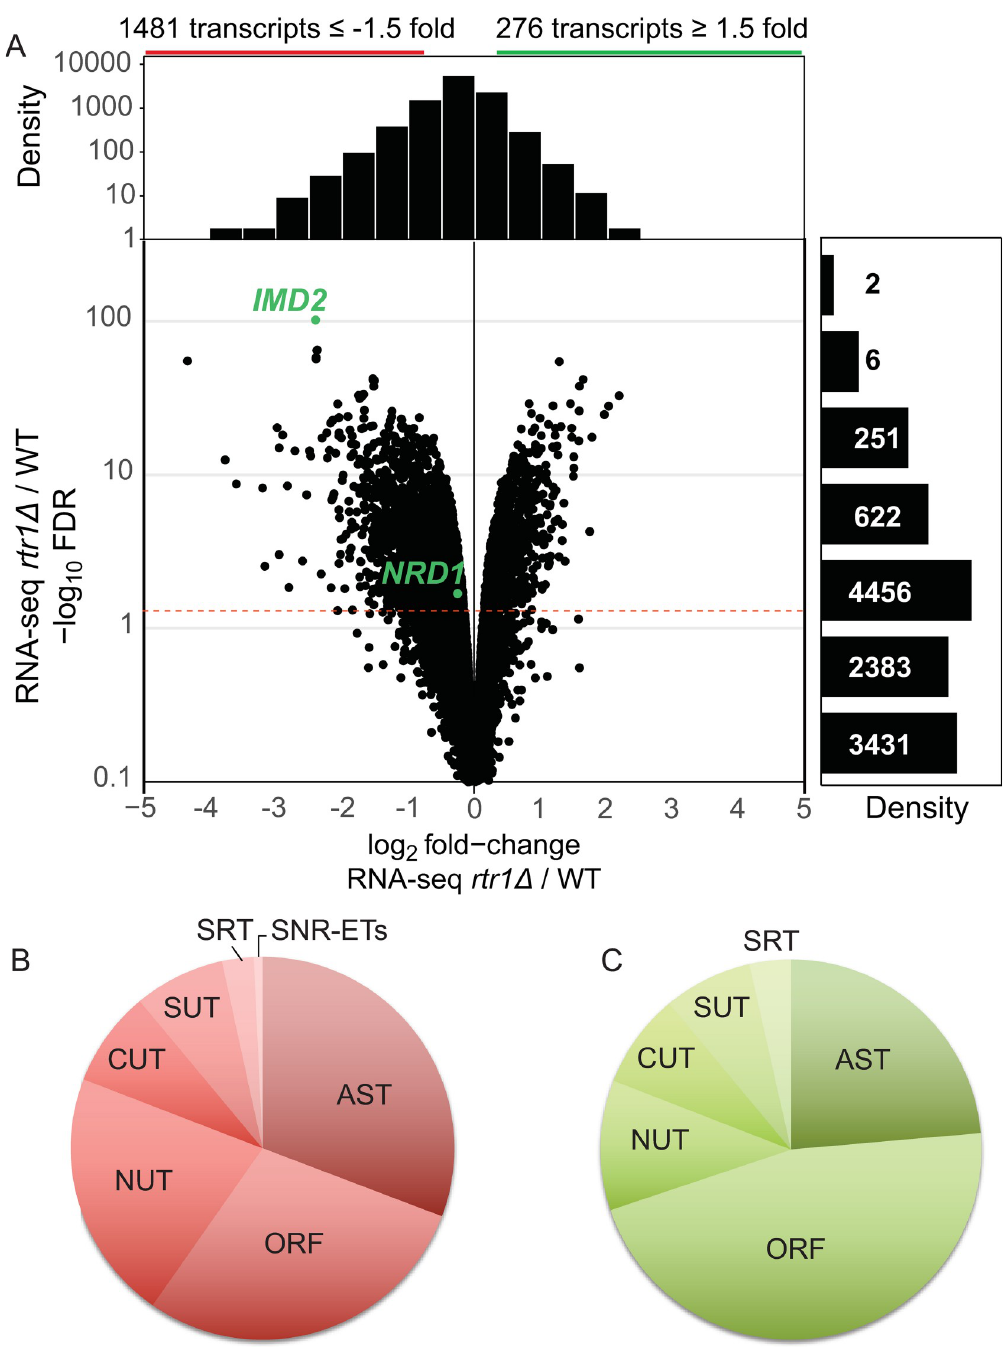
Fig 2. Loss of Rtr1 activity causes wide-spread changes in RNA expression in yeast. A) Volcano plot for normalized RNA-Seq data for RNA transcripts in rtr1 Δ vs. WT cells (n = 4, edgeR analysis). Data is shown for all annotated ORF-Ts cryptic unstable transcripts (CUTs), Nrd1 unterminated transcripts (NUTs), SNR extended transcripts, Ssu72 restricted transcripts (SRTs), and antisense transcripts (ASTs). False discovery rates (FDR) were calculated by edgeR and a cutoff of � 0.05 is indicated with a dashed red line. Density plots are shown relative to each axis for comparison. B&C) Distribution of transcripts differentially expressed in rtr1 Δ cells compared to WT across annotation categories. Downregulated transcripts are represented in the red diagram while upregulated transcripts are represented in the green diagram. In addition to the FDR cutoff of � 0.05, transcripts were considered differentially expressed with a fold-change value of at least +/-1.5-fold.